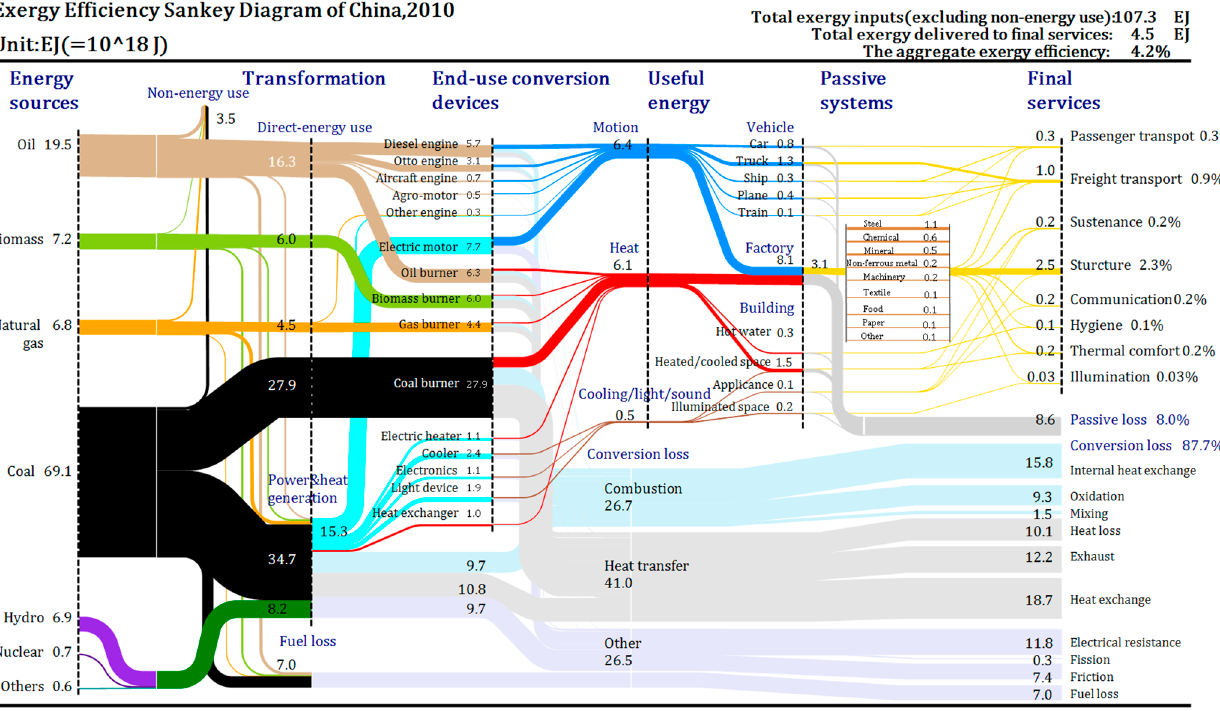
Figure 7. Exergy efficiency Sankey diagram from the energy source to final service of China in 2015. According to the diagrams in Figures 5–7, the main features of changes of the aggre- gate exergy efficiency of China’ energy system are identified and discussed: (1) The aggregate exergy efficiency of China from the energy source to final service was just 3.7% in 2005, 4.2% in 2010, and 4.8% in 2015. This shows an increasing trend;